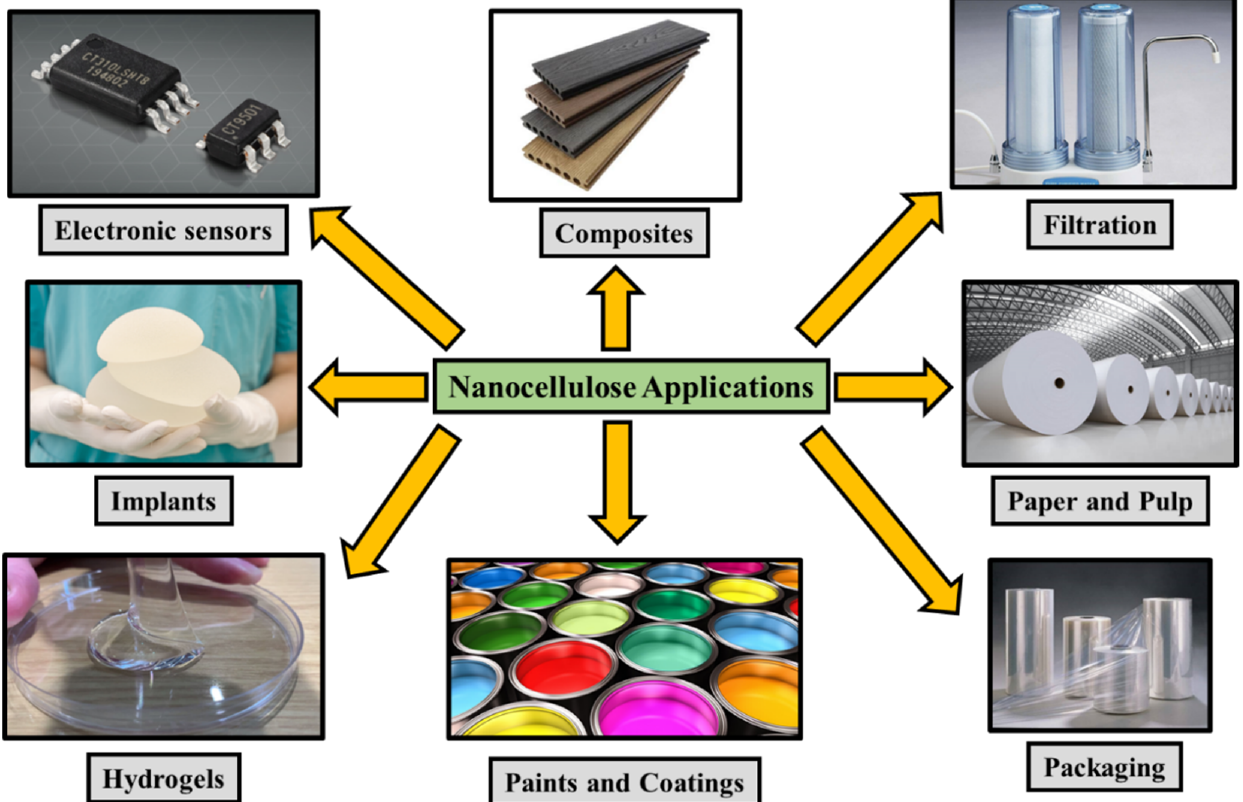
Figure 9. Applications of nanocellulose and its composites.